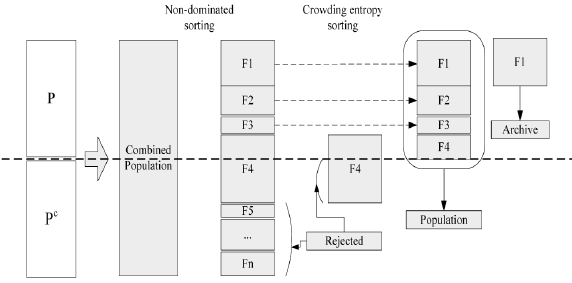
Fig. 2. Select population and create Archive